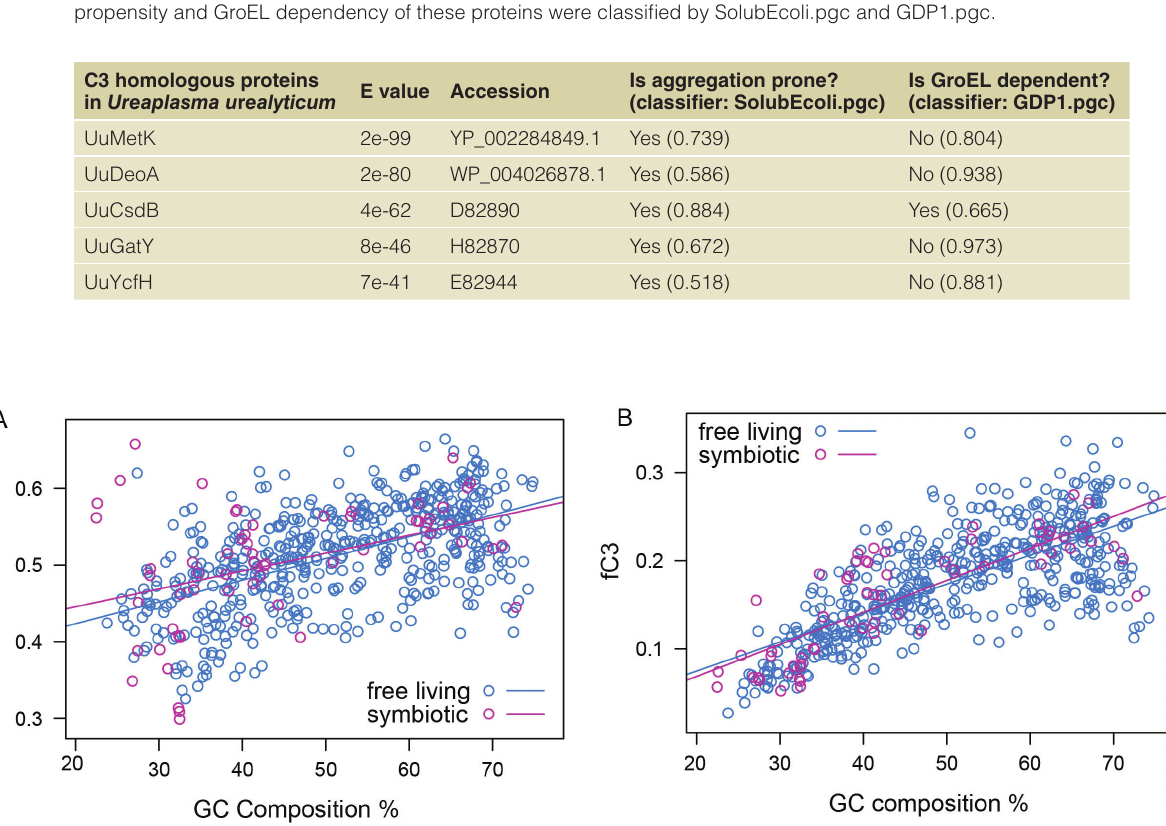
Table 3. Evaluation of classifiers on five C3 homologous proteins of groEL-lacking Ureaplasma urealyticum . The homologous were found in U. urealyticum by NCBI BLAST at a threshold of E value of 1e45. Then the aggregation